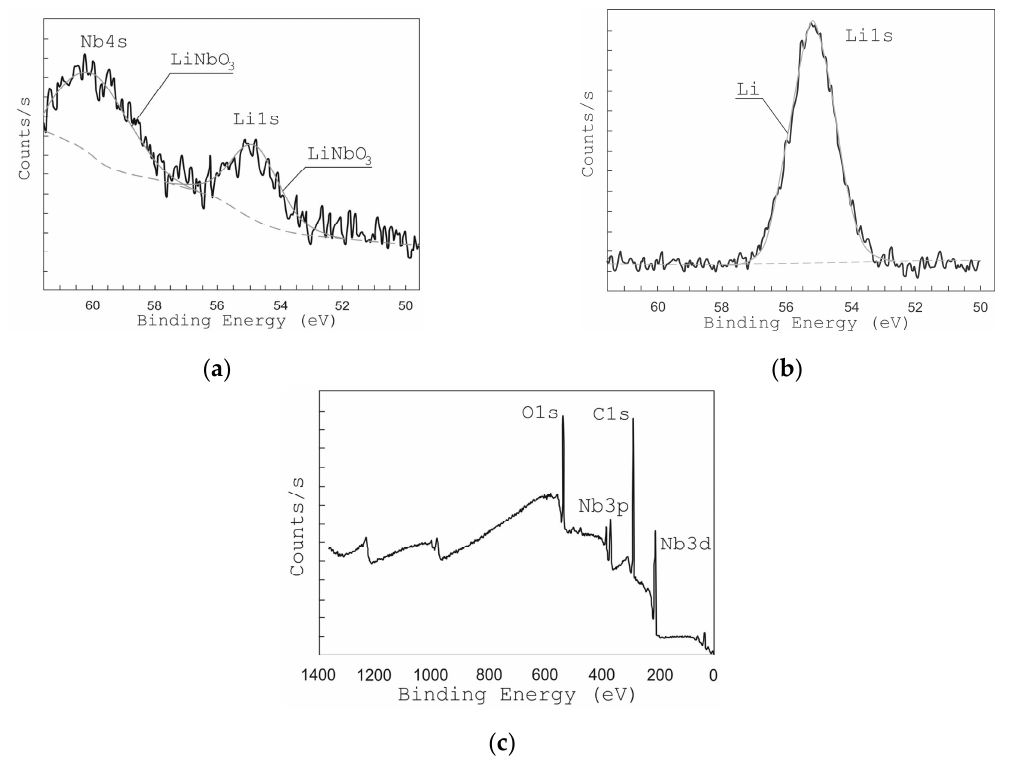
Figure 5. X-ray photoelectron spectroscopy (XPS) peaks from Li 1s and Nb 4s of films grown at different oxygen pressures: 1 × 10 − 2 Torr ( a ) and 1 × 10 − 5 Torr ( b ), and survey XPS spectra of LiNbO 3 film ( c ).